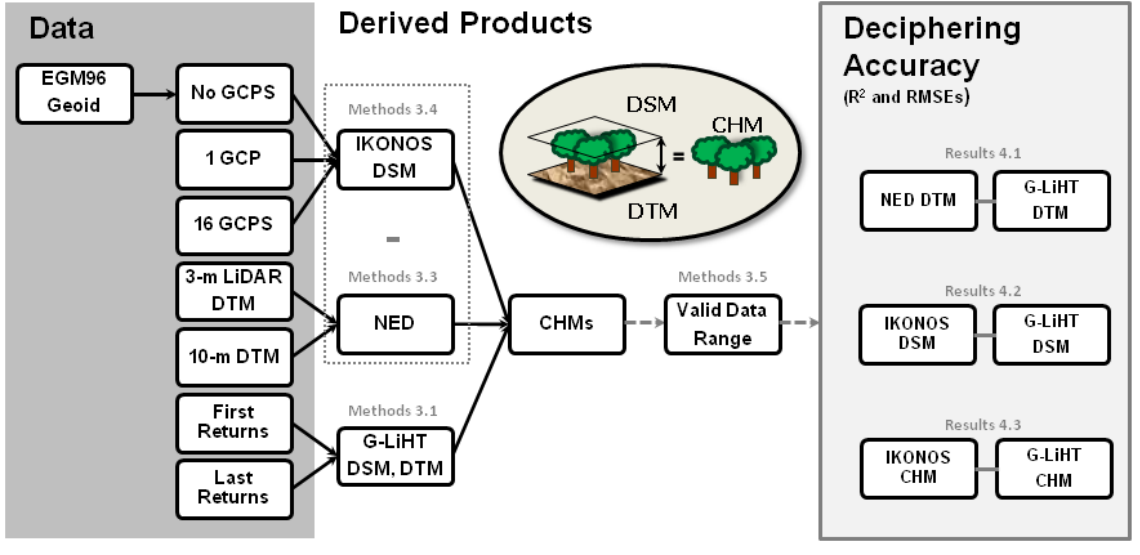
Figure 2. Schema of how data were compared to decipherer components that impact IKONOS canopy height model (CHM) error. The left portion describes data used in analysis, center describes derived data products, and the right portion describes the comparison of